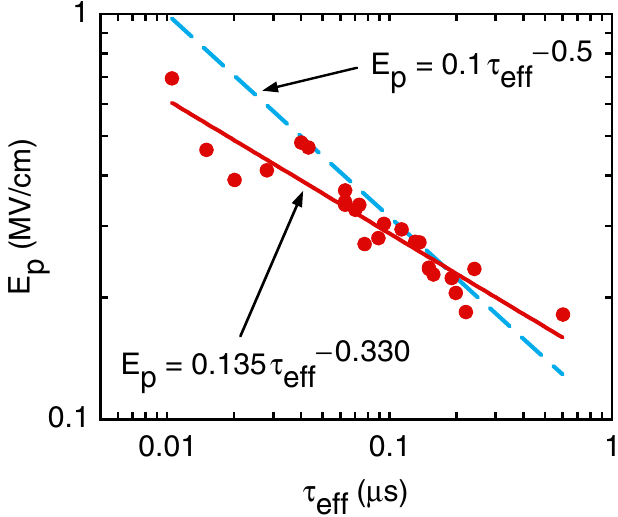
FIG. 1. (Color) The peak electric field required to achieve as a function of the effective pulse complete dielectric failure E p width (cid:1) . Each of the 25 measurements plotted here was eff obtained with a significantly field-enhanced anode and a less- enhanced cathode, as described in Refs. [27,42–46,50]. This =d , where V as V data is summarized in Table I. We define E p p p is the peak voltage in time across the anode-cathode gap, and d is to be the width of the voltage the length of the gap. We define (cid:1) eff pulse at 63% of peak. It appears that the data are more consistent with Eq. (5) than Eq.